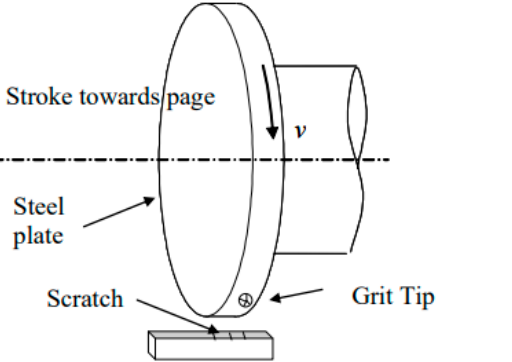
Figure 4. Schematic of horizontal single grit test rig. Reprinted from Griffin 2015 [21].